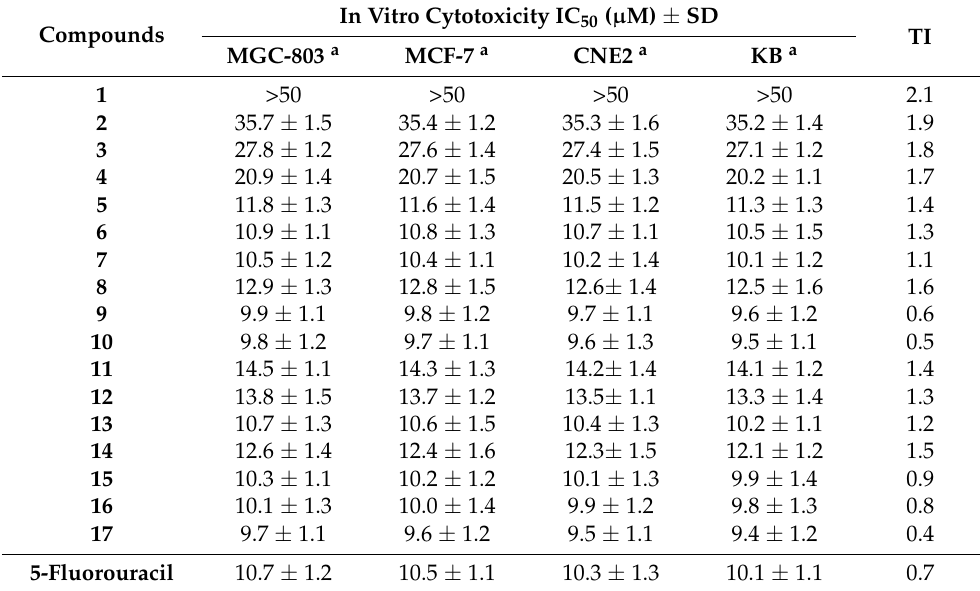
Table 1. Cytotoxic activities of the new isatin derivatives against diverse human cancer cell lines.